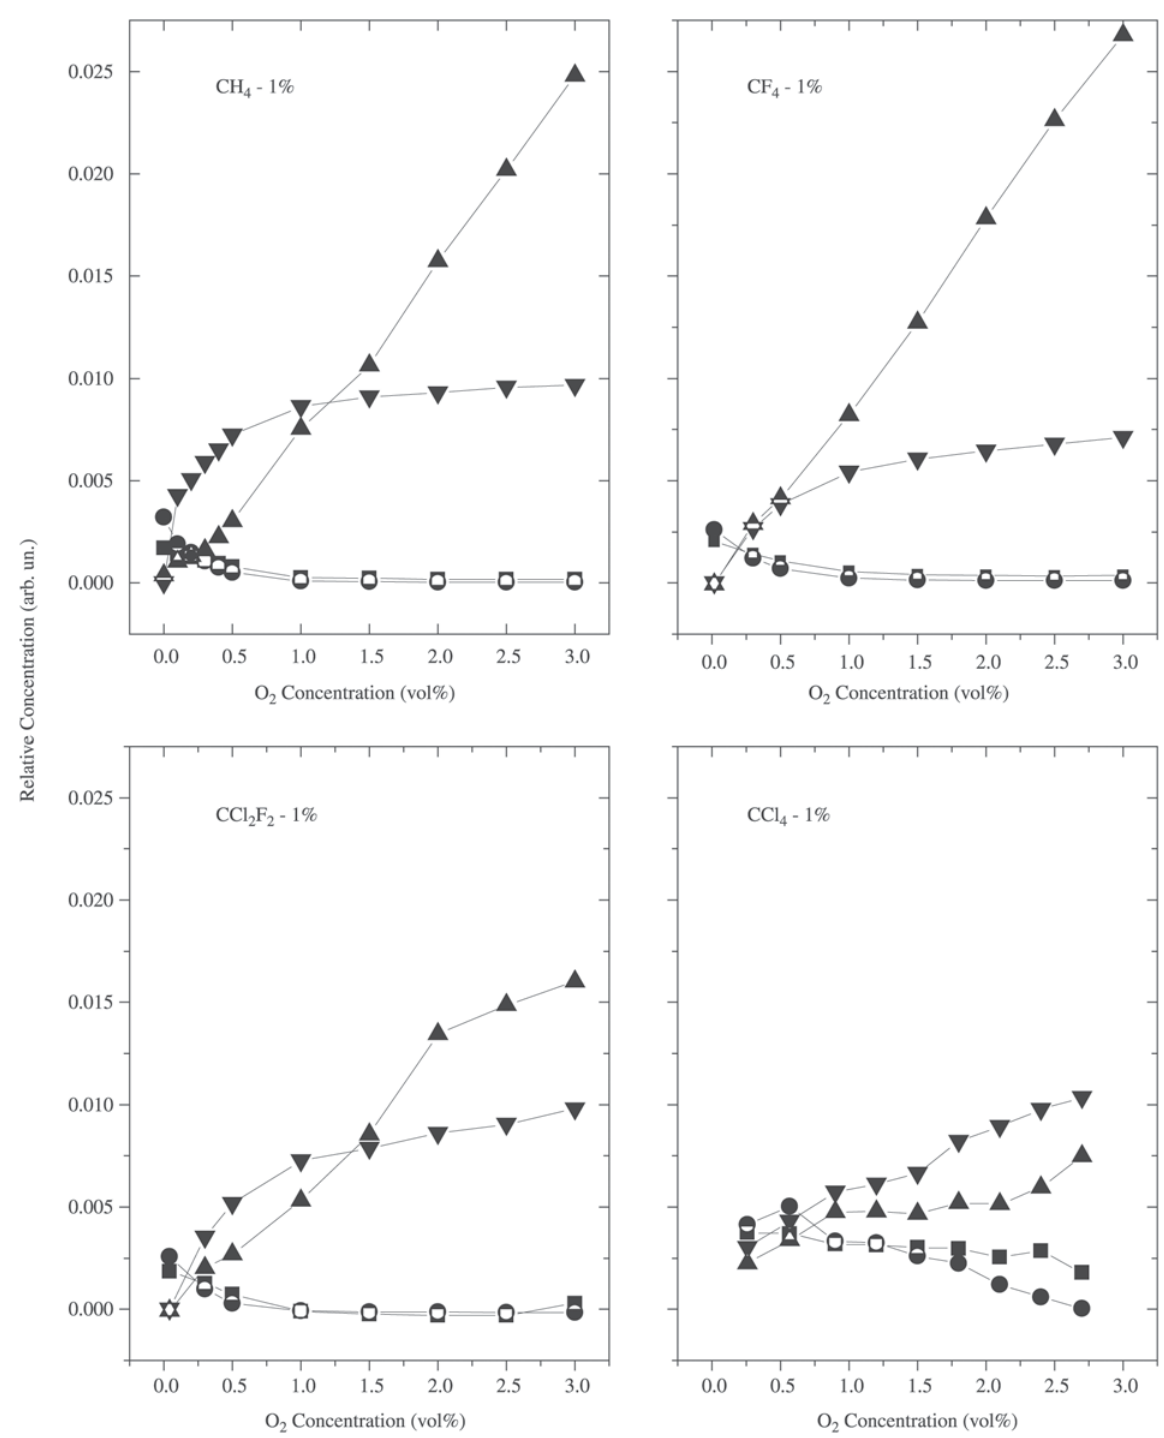
Figure 4. Relative concentration of the stable species in the exhaust gas as a function of oxygen concentration in the inlet gas for mixtures of 1 vol% CH